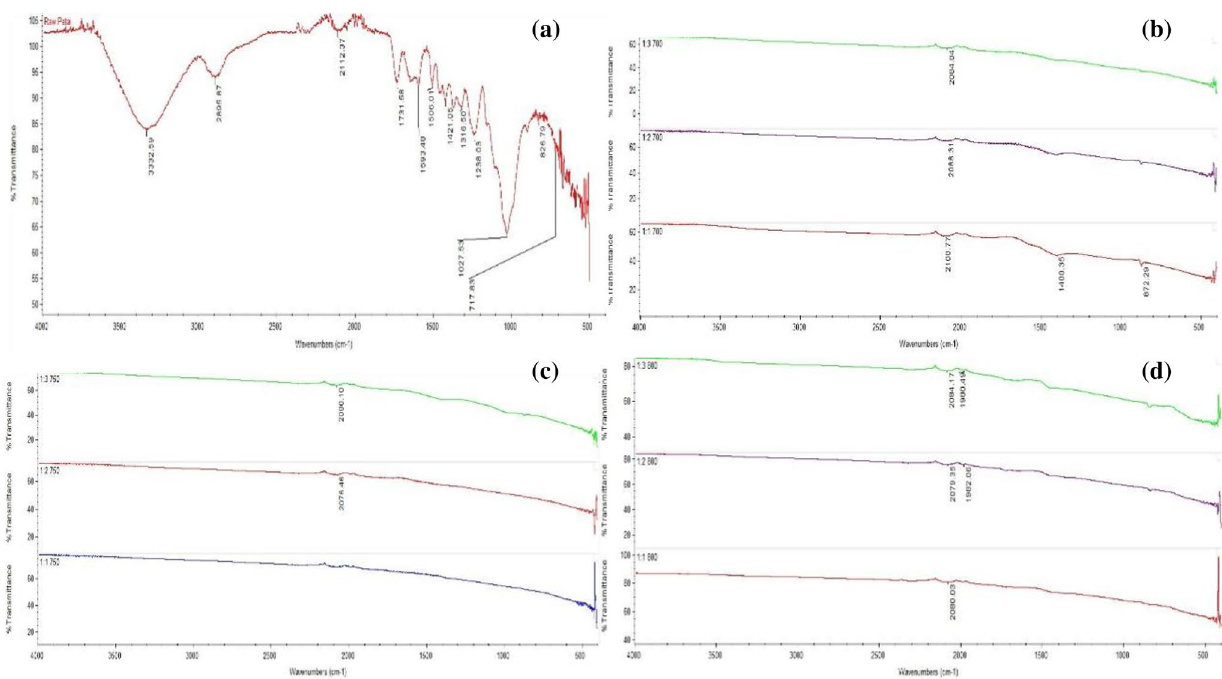
Fig. 3 FT-IR spectra for raw Leucaena leucocephala biomass a , samples with activation temperature 700 °C, b 750 °C, and c 800 °C d